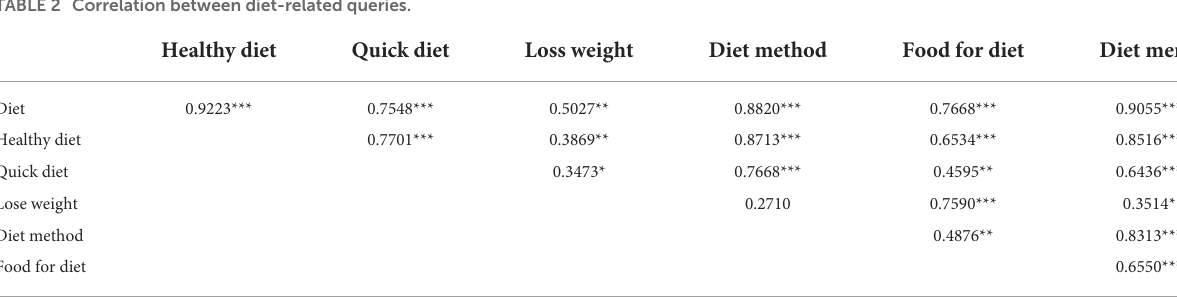
TABLE 2 Correlation between diet-related